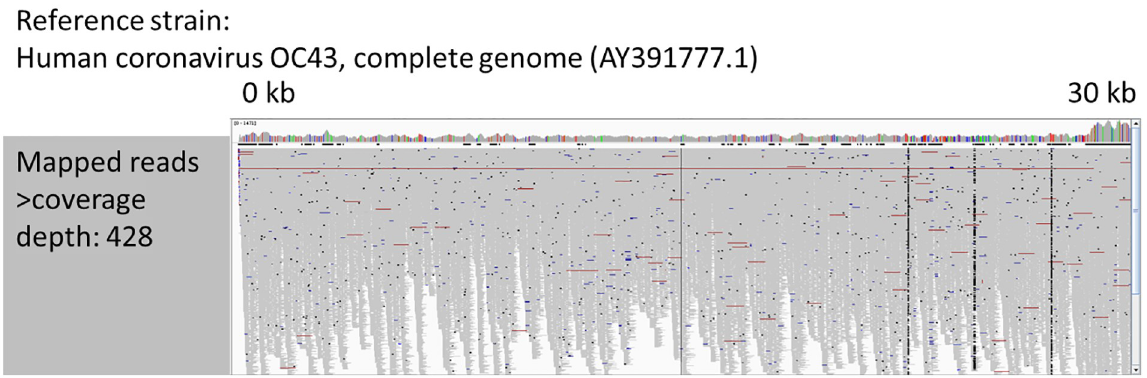
Fig 1. Coverage plot of betacoronavirus reads to coronavirus OC43 reference genome AY391777.1 (depth of coverage: 428).